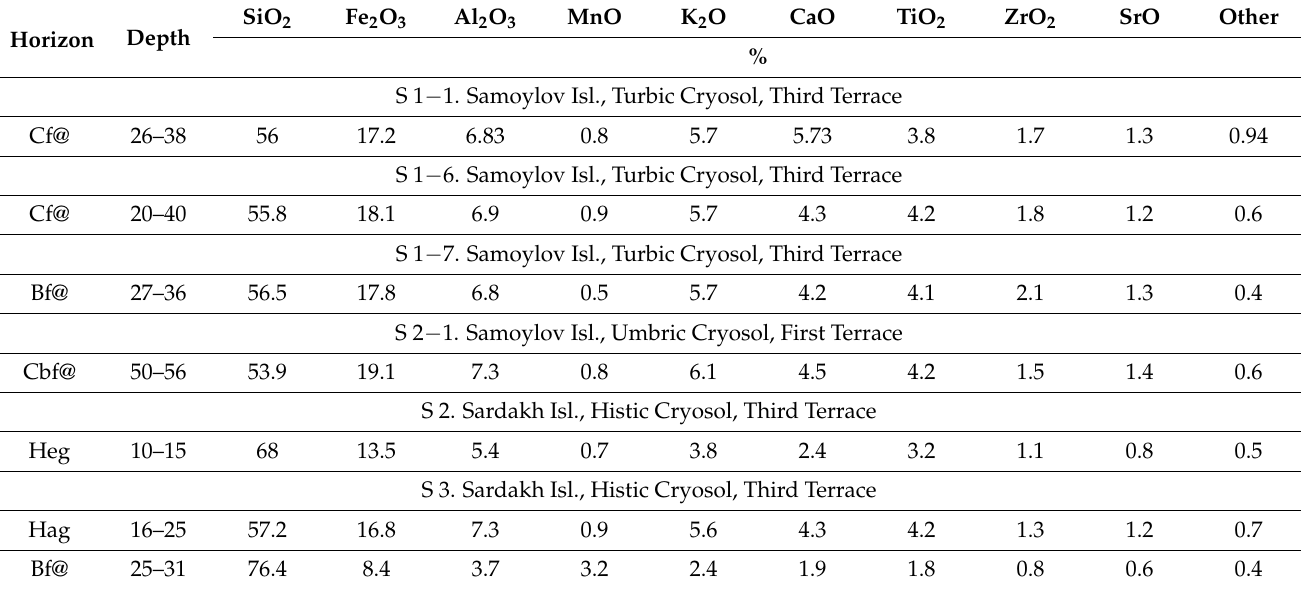
Table 4. X-ray Fluorescence Analysis of Study Soils.